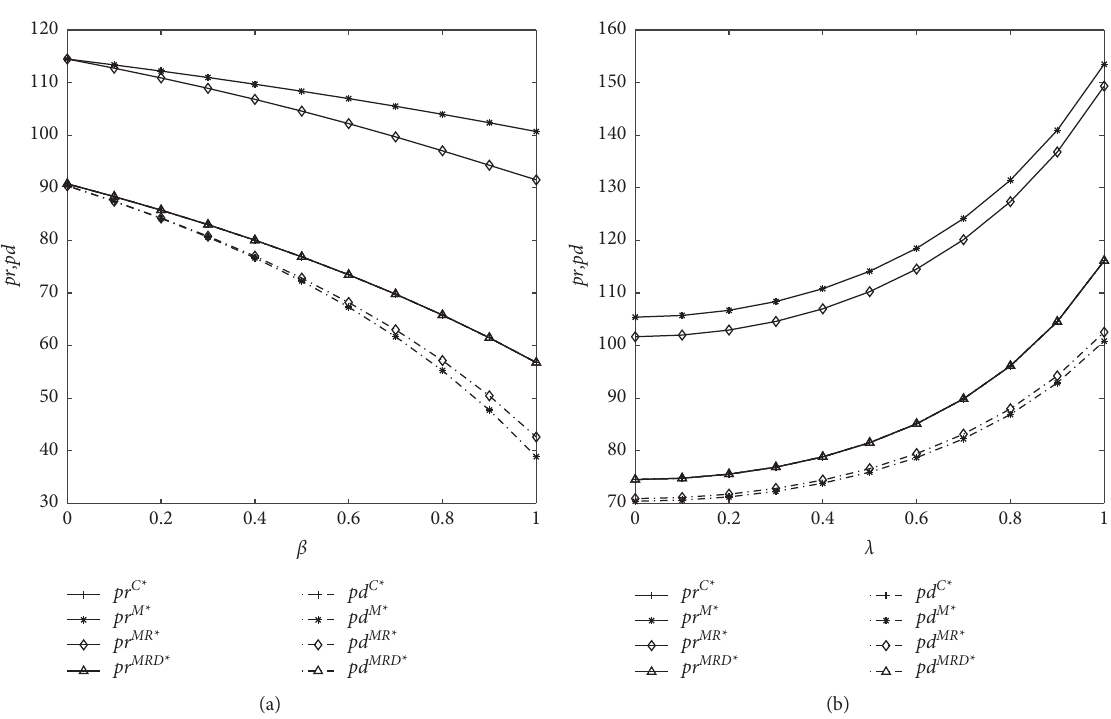
Figure 2: The effect of β and λ on online and offline selling